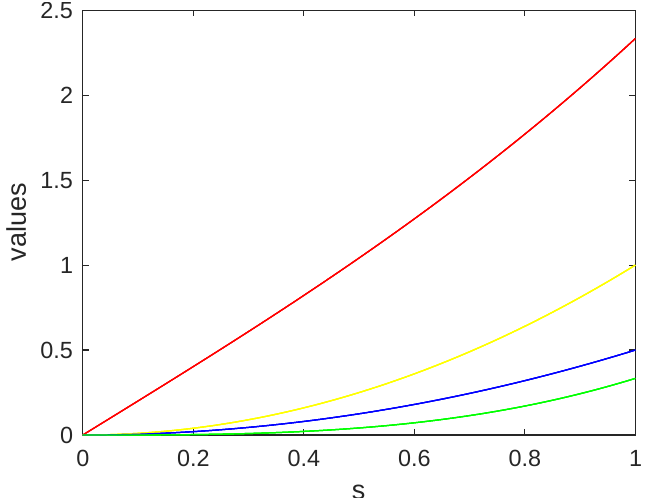
is shown as a red, s 2 is shown as a yellow, s 2 3